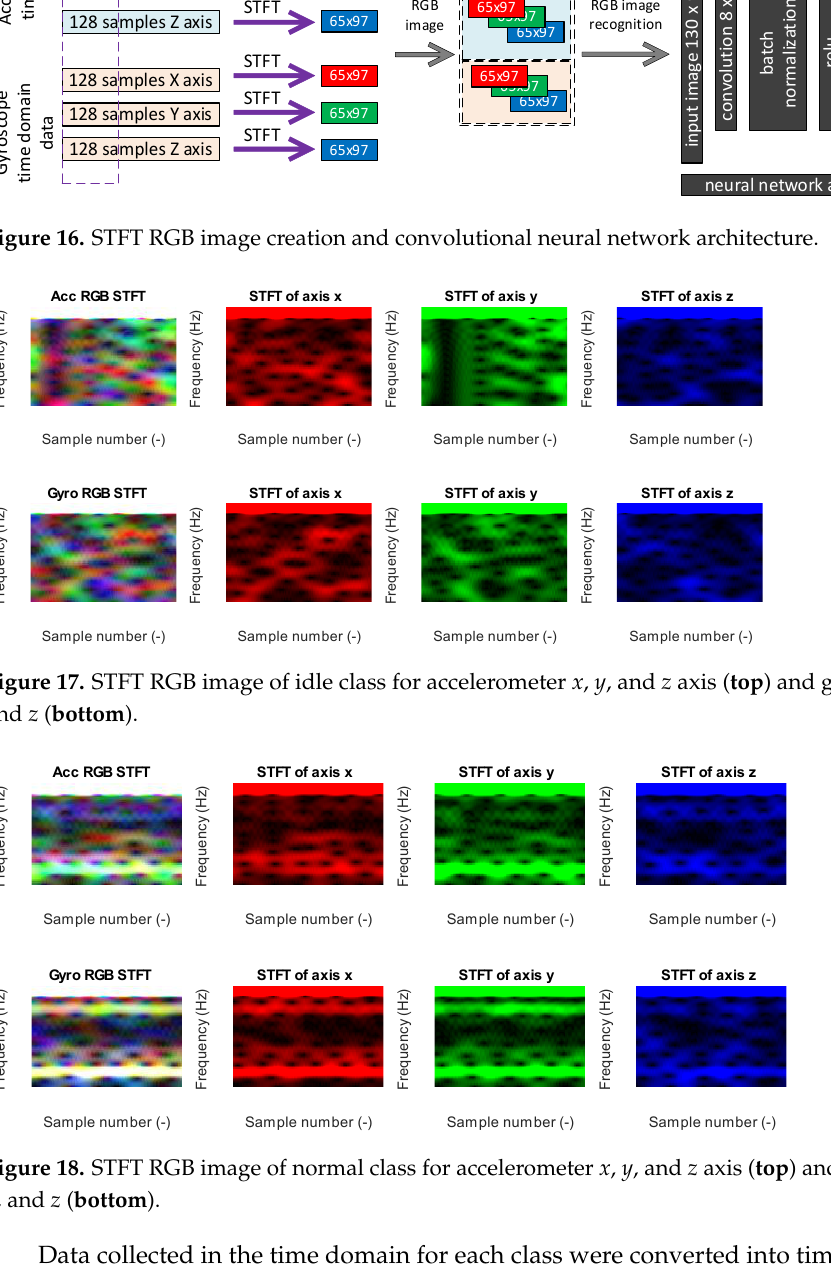
Figure 19. STFT RGB image of the fault class for the accelerometer x , y , and the z axis ( top ) and gyroscope x , y , and z ( bottom ).